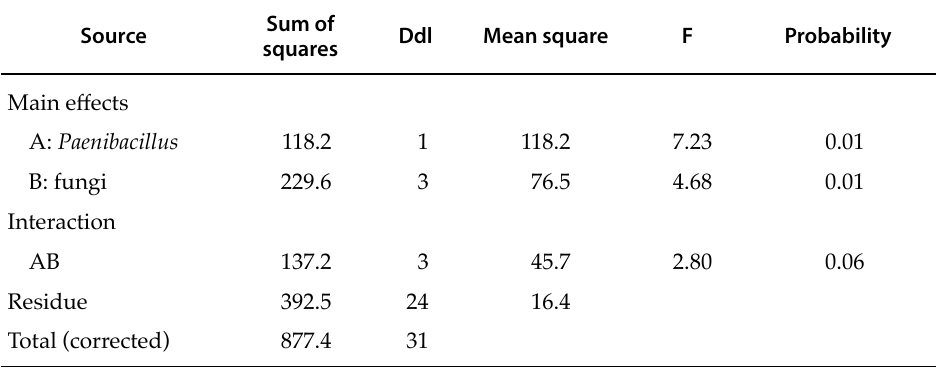
Table 7. ANOVA for “Shoot dry weight” in mg - type III Sum of squares Sum of Ddl Mean square F Probability Source squares